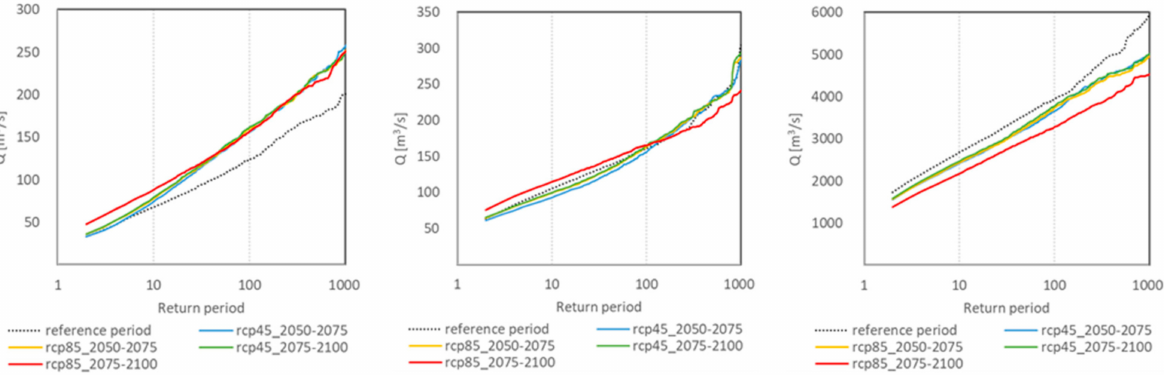
Figure 5. Example of the changed design flows per scenarios in comparison with the reference period for rivers within Elbe basin: Catchment size: left —451 km 2 , middle —1157 km 2 , right —41,831 km 2